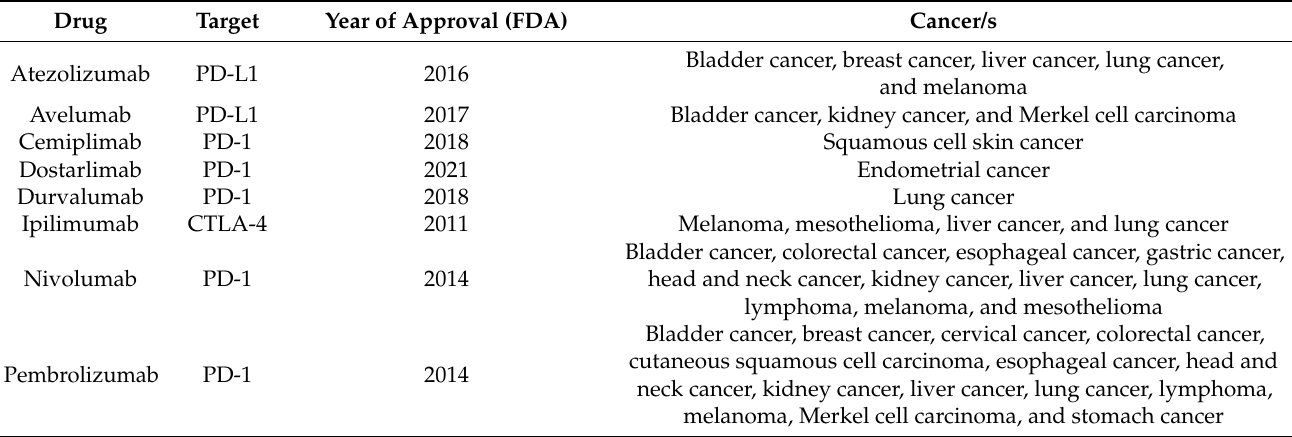
Table 1. Currently approved ICIs with their indications. (CTLA-4, cytotoxic T-lymphocyte-associated protein 4; PD-1,